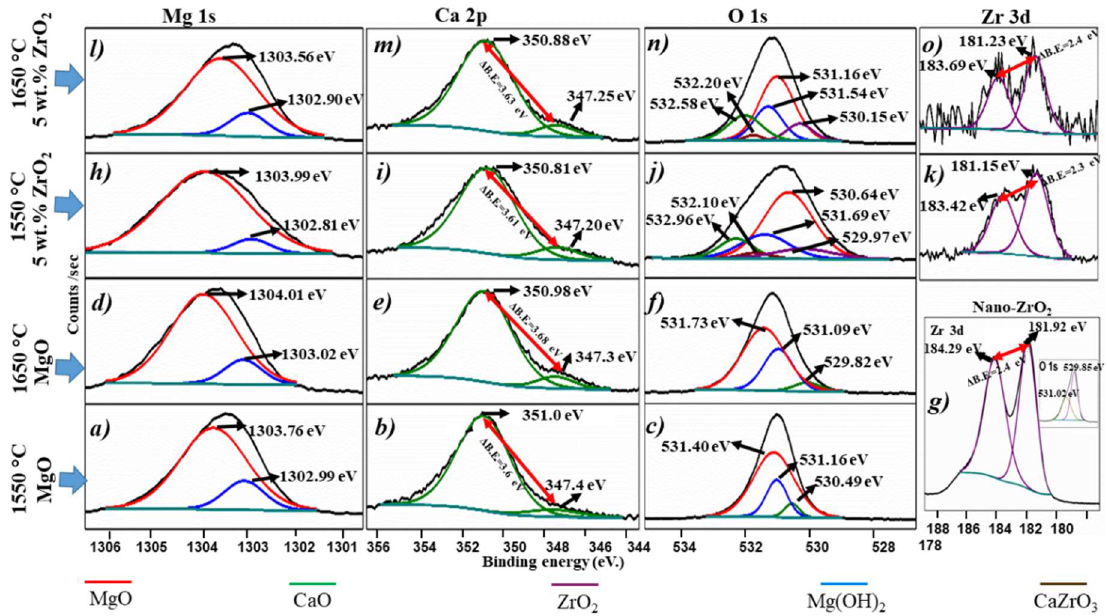
Figure 6. XPS high-resolution spectra of ( a ) Mg 1 s, ( b ) Ca 2 p, and ( c ) O 1 s of MgO sintered a 1550 °C, ( d ) Mg 1 s, ( e ) Ca 2 p and ( f ) O 1 s of MgO sintered a 1650 °C. Spectra in ( g ) correspond to Zr 3 d for nanoparticles of ZrO 2 . The image in the inset in ( g ) shows two peaks; one corresponds to the O 1 s spectra of nano-ZrO 2 (higher peak) and the other to C 1 s corresponding to carbon tape. ( h – o ) Spectra of Mg 1 s, Ca 2 p, O 1 s, and Zr 3 d correspond to samples with 5 wt.% of ZrO 2 nanoparticles sintered at 1550 °C and 1650 °C, respectively.